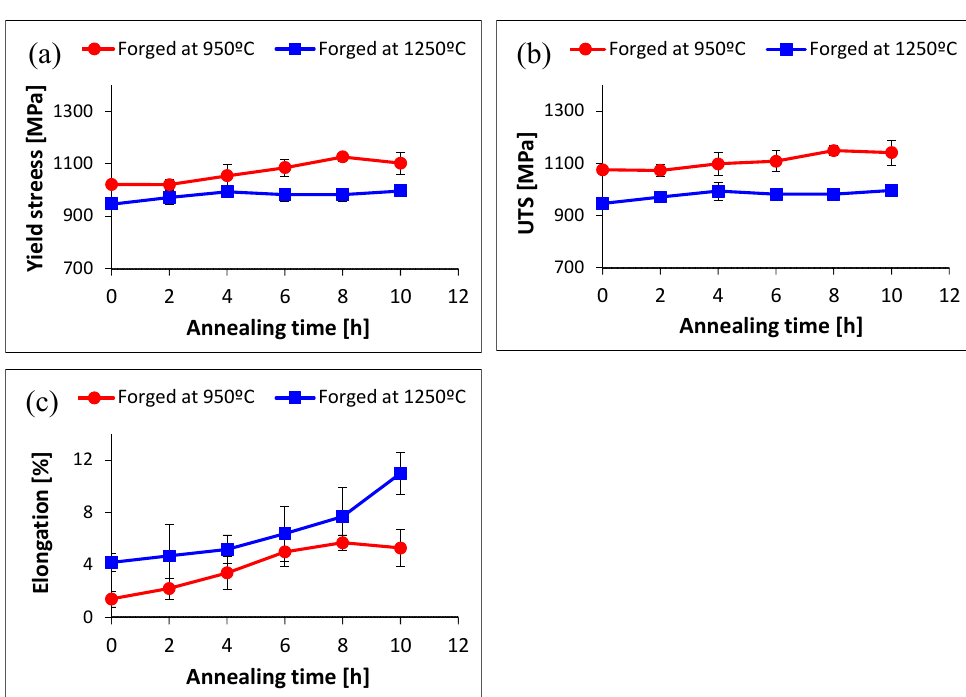
Figure 4. Variation in the mechanical properties of the forged Ti-5Al-2.5Fe alloy as a function of the annealing time: ( a ) yield stress, ( b ) ultimate tensile strength, and ( c ) elongation to fracture.